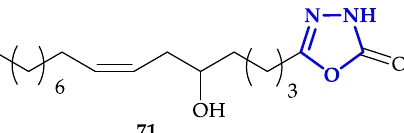
Figure 13. Oxadiazole conjugated to long-chain fatty acid.